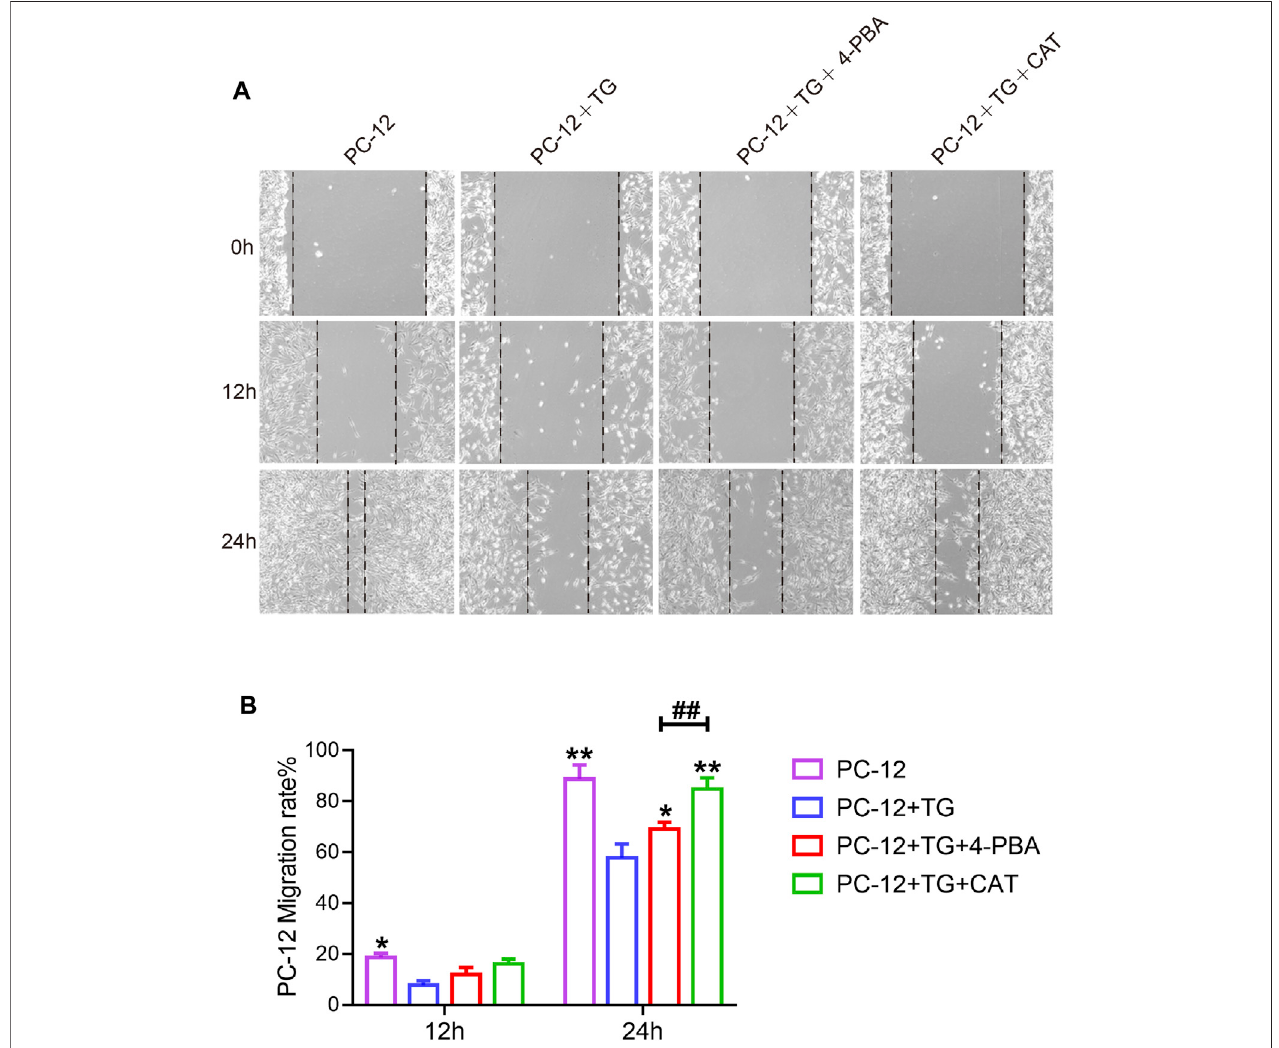
FIGURE 6 | CAT promotes the cell migration of PC-12 cells. (A) Wound healing of the PC-12 group, PC-12 + TG group, PC-12 + TG + 4-PBA group, and PC- 12 + TG + CATgroup.Allimagesweretakenwithaninvertedphase-contrastmicroscope0,12,and24 haftercellscratches. (B) ThemigrationrateofcellsfromthePC- 12 group, PC-12 + TG group, PC-12 + TG + 4-PBA group, and PC-12 + TG + CAT group. A two-way analysis of variance (ANOVA) test was used to analyze cell migration results, and then Dunnett ’ s post hoc test was used. In the 12 h group, “ * ” represents p < 0.05 versus the PC-12 + TG group. In the 24 h group, “ * ” represents p < 0.05, “ ** ” represents p < 0.01 versus the PC-12 + TG group, “ ## ” represents p < 0.01 comparing the PC-12 + TG + 4-PBA group to the PC- 12 + TG + CAT group with statistical signi fi cance. Data are represented as mean ± SD ( n = 3).